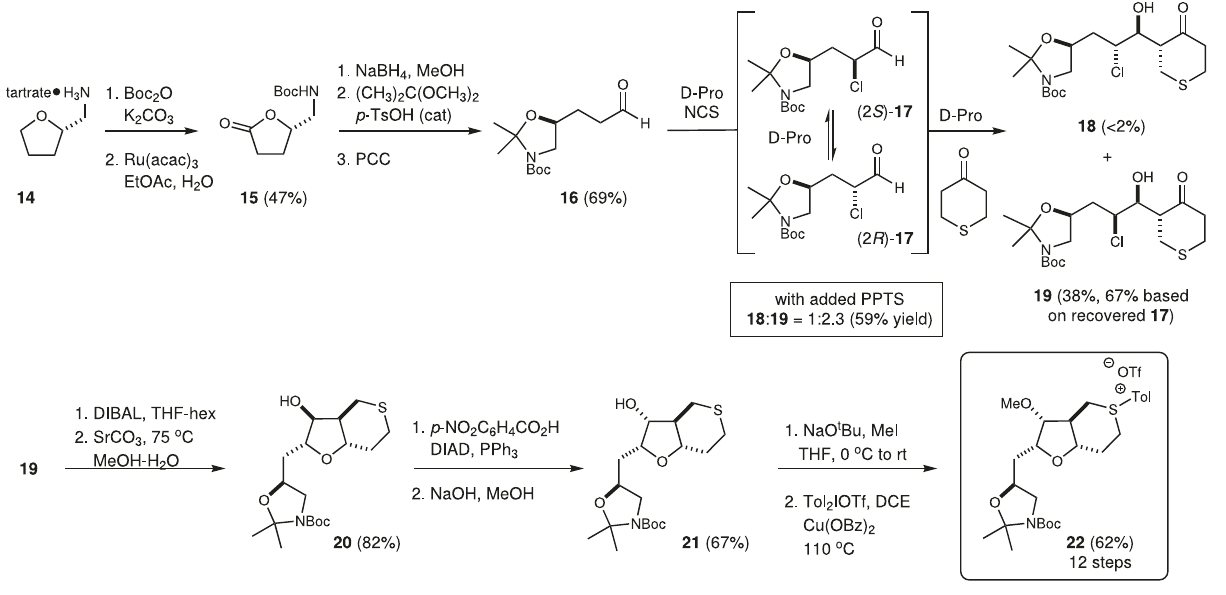
Fig. 2 | Synthesis of the C27 – C35 sulfonium 22. A one-pot proline-catalyzed α - chlorination/aldolreactionprovidesrapidaccesstothechlorohydrin 19 ,whichcan be converted into the sulfonium salt 22 in preparation for the